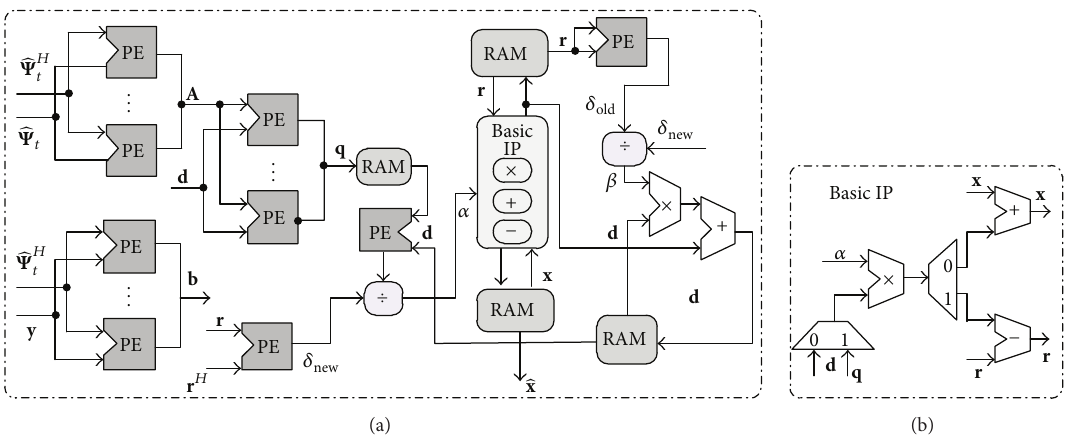
Figure 4: (a) Hardware structure of LS. (b) Inner structure of basic IP.